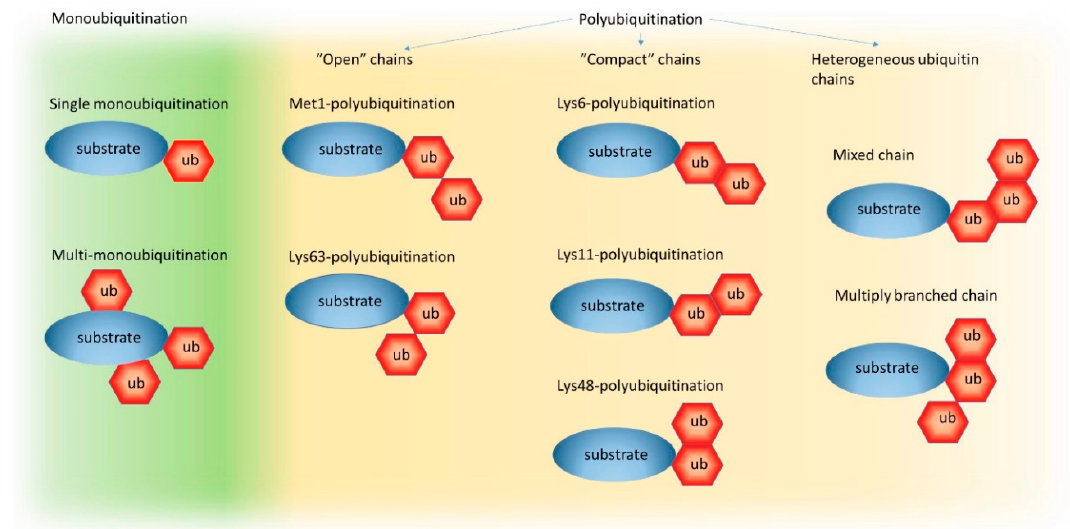
Figure 1. The ubiquitin code. A schematic representation of possible ubiquitin (Ub) chain formations on a target protein (substrate) from single mono-ubiquitination to mixed and multiply -branched Ub chains. Within polyubiquitin chains, which can exist on one of the seven intrinsic lysine (Lys) residues within the Ub sequence, or methionine (Met) at position 1, Ub can form eight different homogeneous or heterogeneous linkage types. However, only five linkage types have been structurally characterized (Met1-chains, Lys6-chains, Lys11-chains, Lys48-chains, and Lys63-chains) and classified as “open” or “compact” based on their three-dimensional topologies.